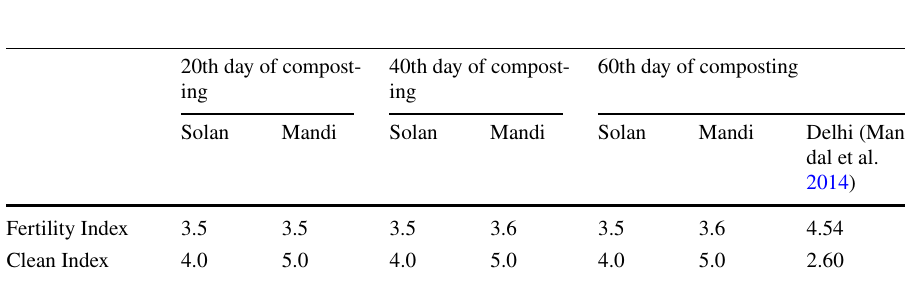
20th day of compost- ing